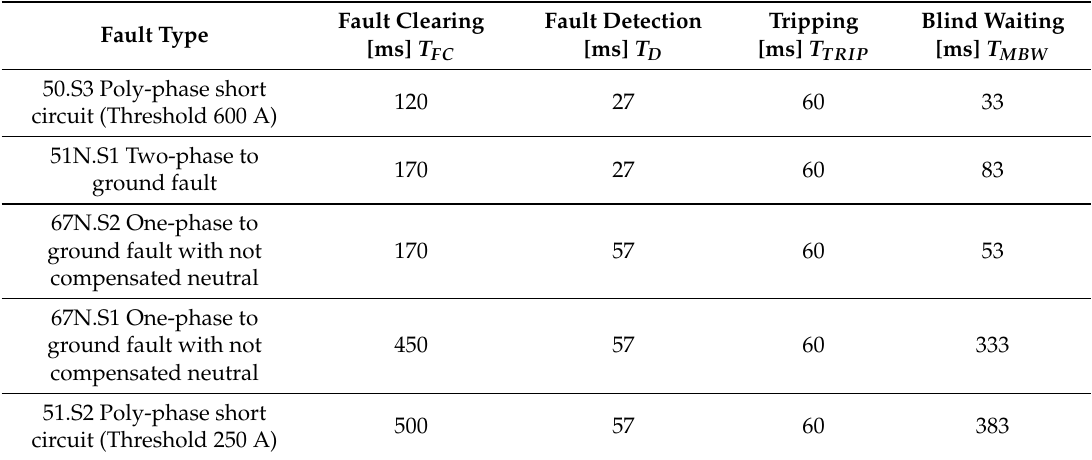
Table 9. Times for fault clearing, detection, tripping, and blind waiting depending on the fault